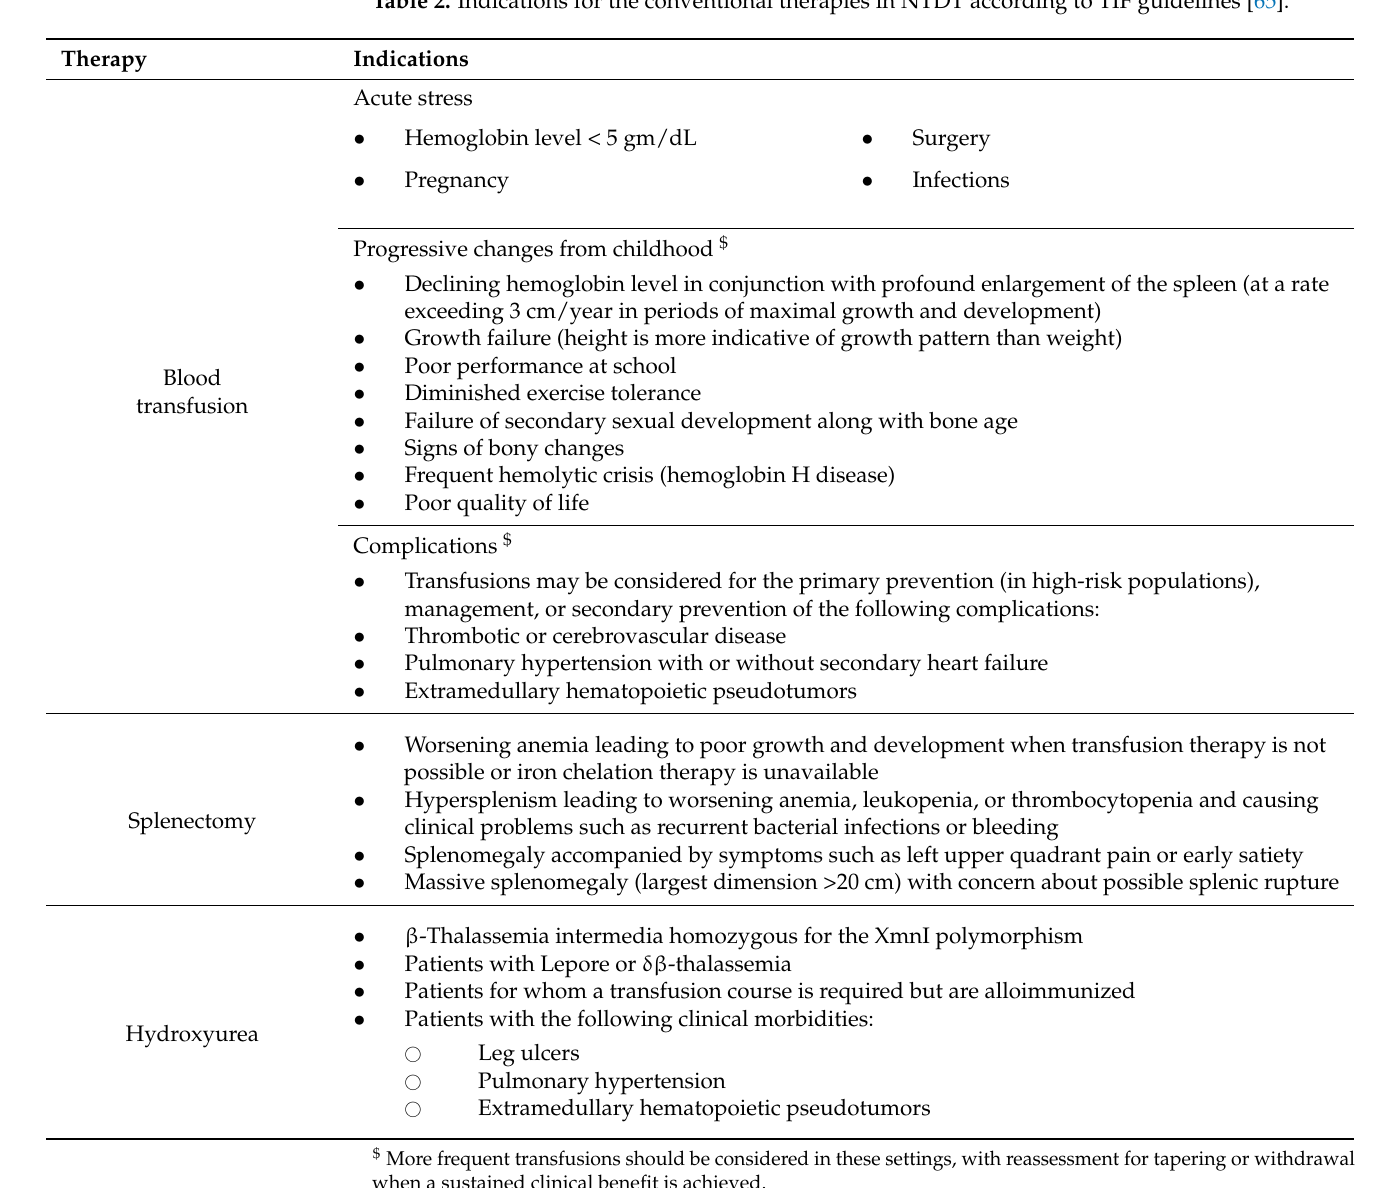
Table 2. Indications for the conventional therapies in NTDT according to TIF guidelines